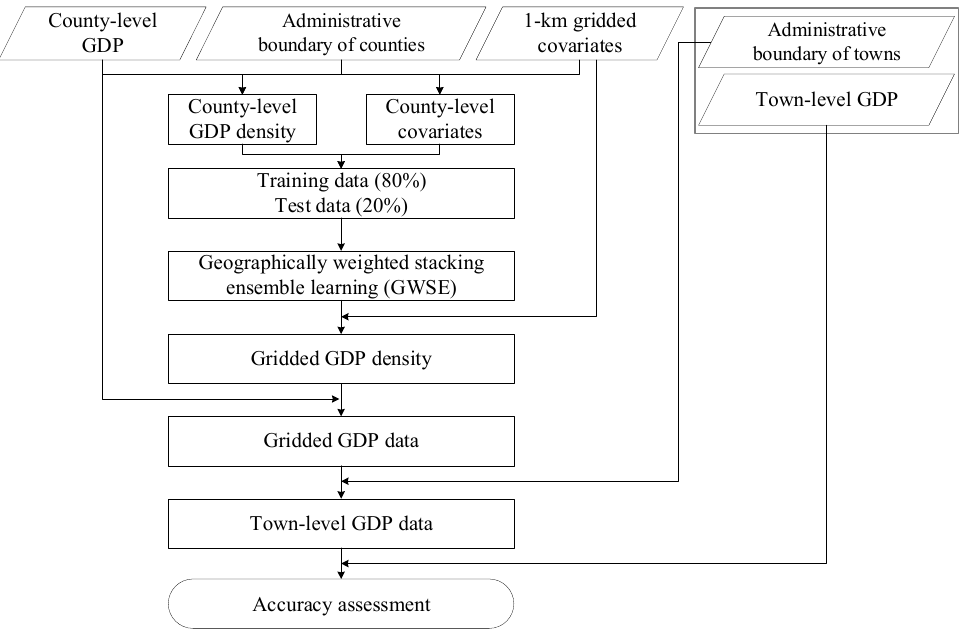
Figure 3. Procedure of GDP downscaling using GWSE.